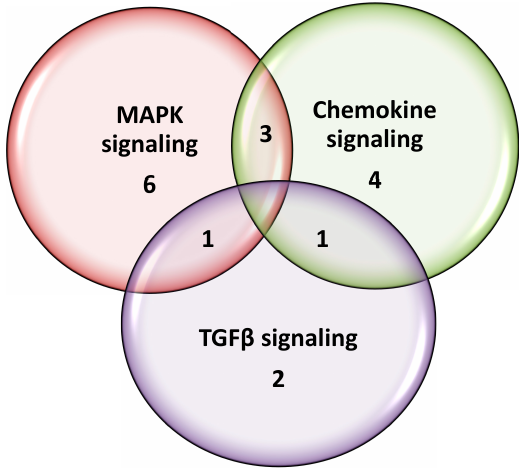
TGF β signaling